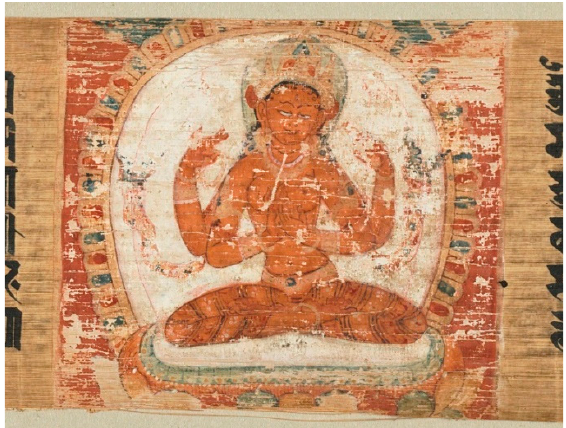
Figure 8. Prajñ ā p ā ramit ā , detail of fol. 90r. Perfection of Wisdom in Eight Thousand Lines: A ṣṭ as ā hasrik ā Prajñ ā p ā ramit ā -s ū tra , 1119. Nepal. Gum tempera and ink on palm leaf. 6.1 × 6.4 cm. Cleveland Museum of Art, purchase from the J. H. Wade Fund, 1938.301.3.